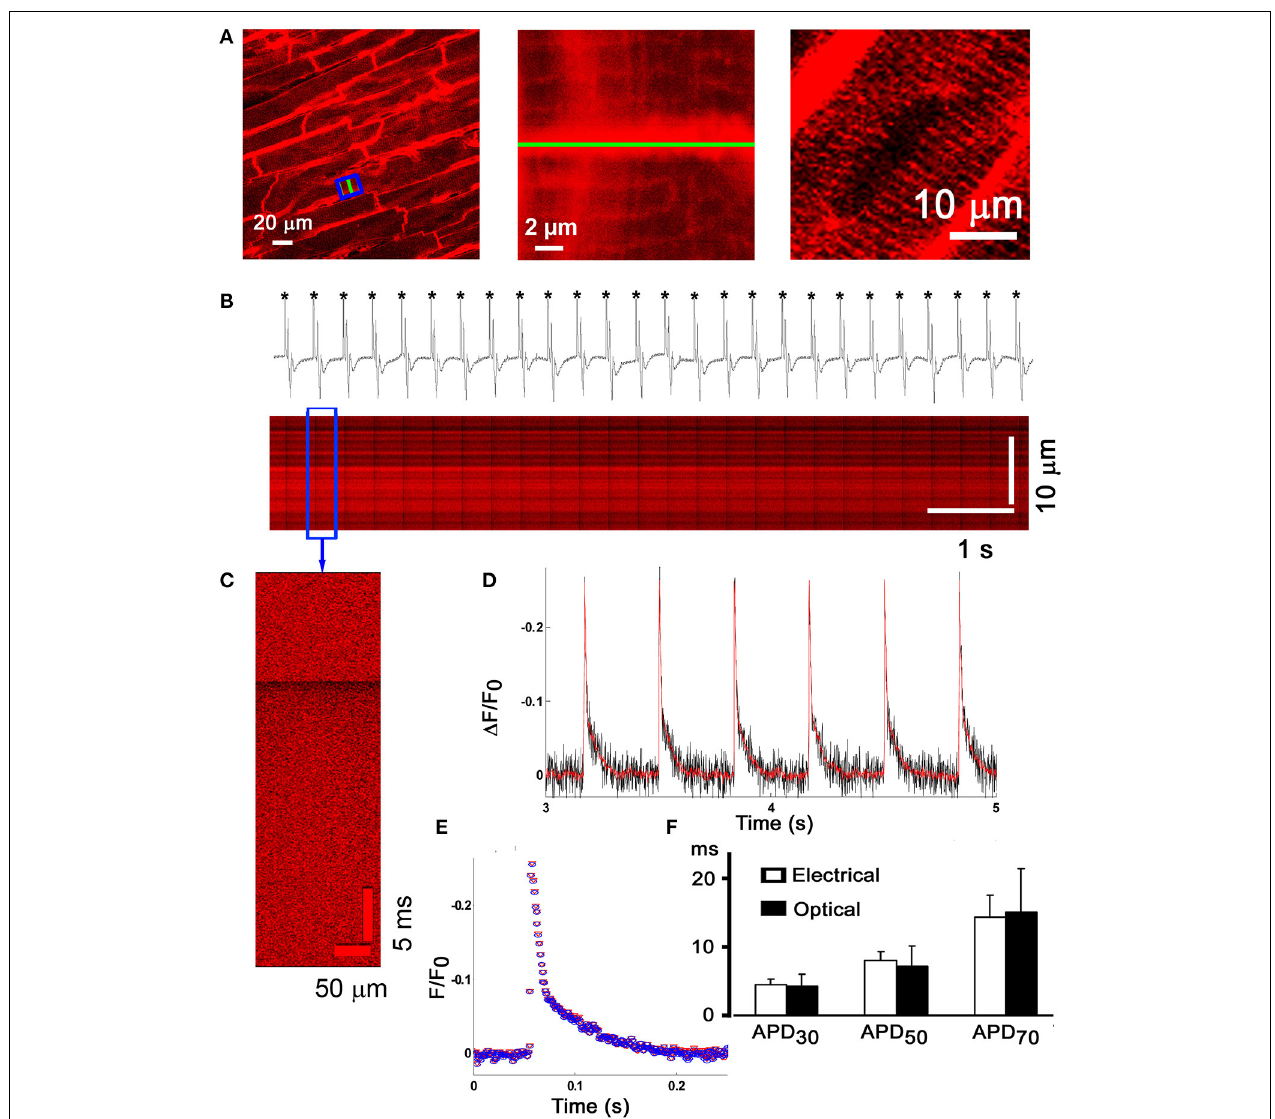
FIGURE 6 | Micron-scale imaging of transmembrane voltage changes in the Langendorff-perfused mouse heart. (A) Frame-mode confocal image taken from the anterior left ventricular epicardial layer of a Langendorff-perfused mouse heart loaded with the fast-response voltage-sensitive dye Annine-6plus (left panel). The dye was excited at 488nm and fluorescence emission was measured at > 560nm. Cytochalasin D (50 μ mol/L) and ryanodine (1 μ mol/L) were present in the coronary perfusate to suppress motion. Middle panel, magnified view of the boxed area in (A) , revealing dye accumulation in the t-tubular membranes (thin lines). Right panel, no staining of the nuclear envelope was detectable more than 3h after dye loading. (B) Line-scan mode image acquisition of action potential-evoked changes in Annine-6plus fluorescence intensity. The green line in (A) (left and middle panel) was repetitively scanned at a rate of 1kHz